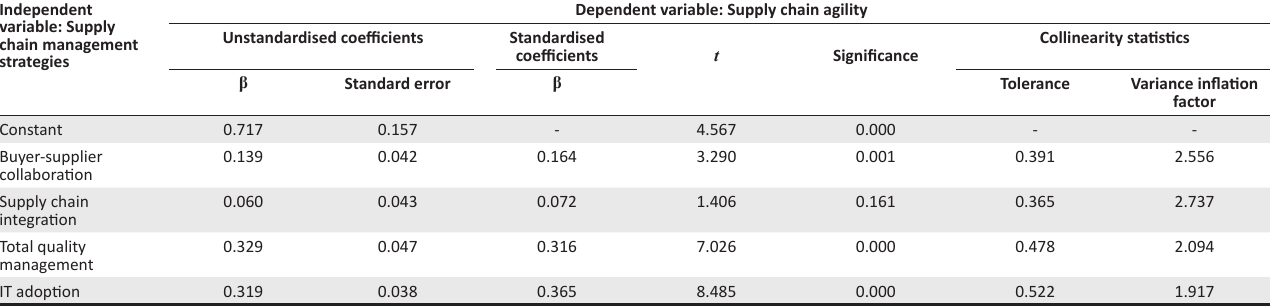
TABLE 4 : Regression model 1: Supply chain management practices and supply chain agility. Independent variable: Supply chain